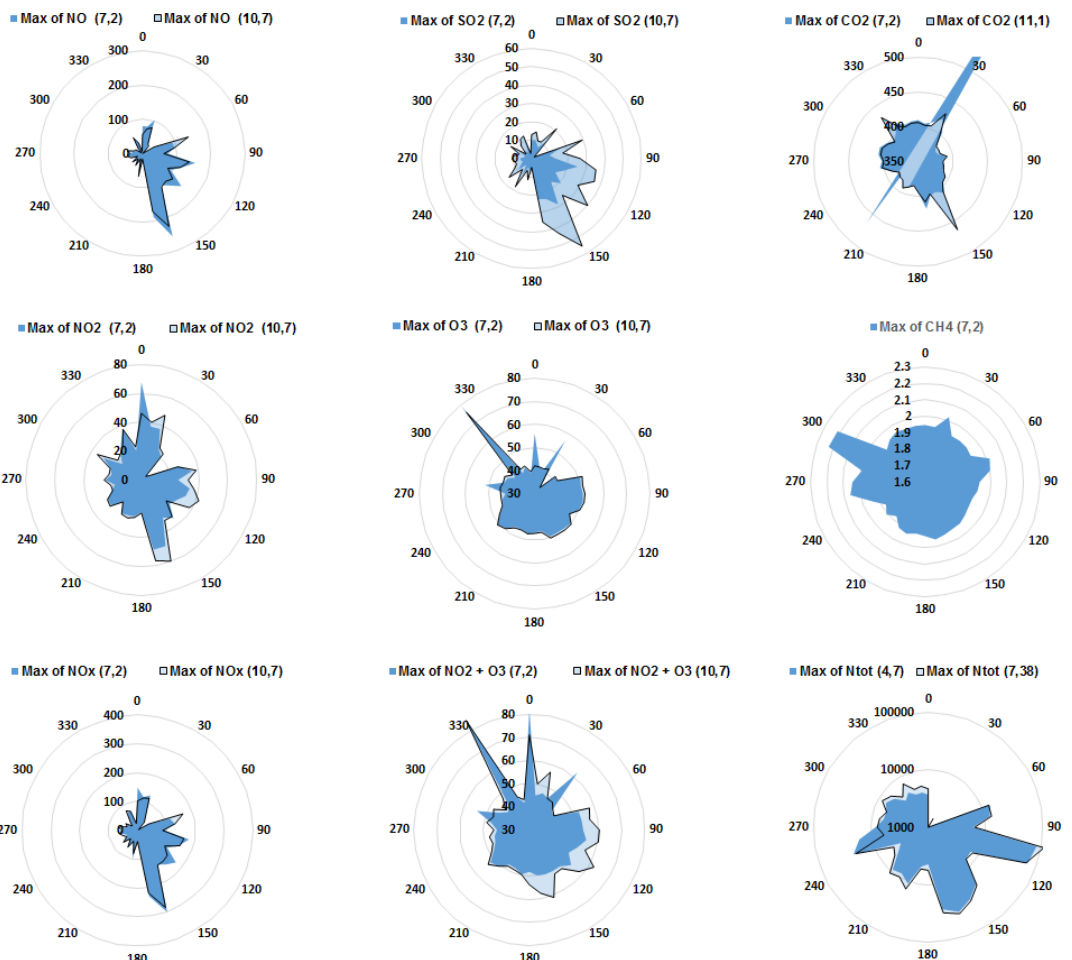
Figure 7. Roses of the maximum gaseous concentrations of nitrogen oxides (NO, NO 2 , NO x ; in ppb), oxidants O 3 and NO 2 + O 3 (in ppb), SO 2 (in ppb), and CH 4 and CO 2 (in ppm). Also shown are the roses of particle concentrations N tot (in cm − 3 ). All roses except for CH 4 were plotted for the two heights; the corrected heights (m) are given in parentheses above the roses. The direction of the coastline is from 240 to 60 ◦